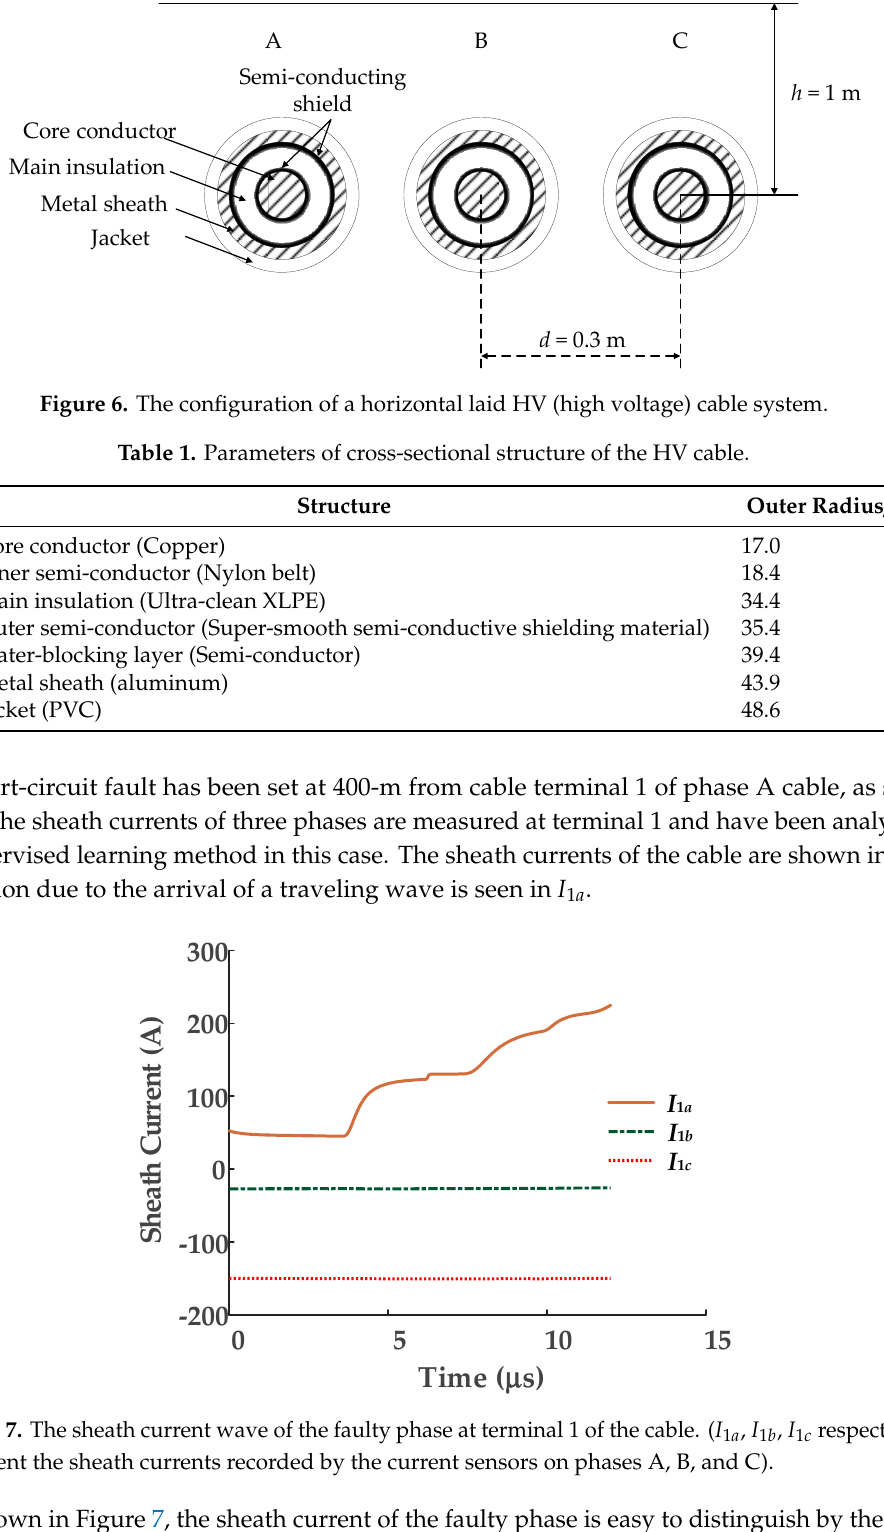
Figure 7. The sheath current wave of the faulty phase at terminal 1 of the cable. ( I 1 a , I 1 b , I 1 c respectively represent the sheath currents recorded by the current sensors on phases A, B, and C).